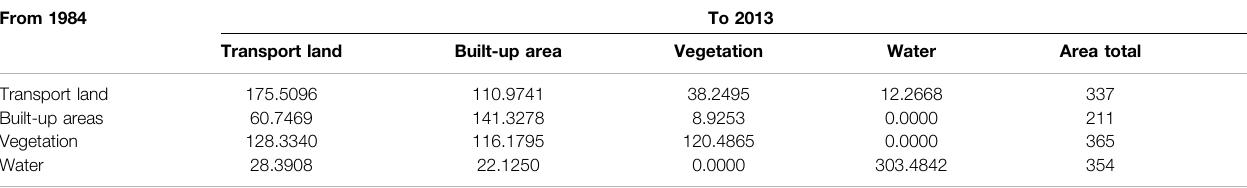
TABLE 4 | Areas of initial state transition matrix for 29years — 1984 to 2013. ( km 2